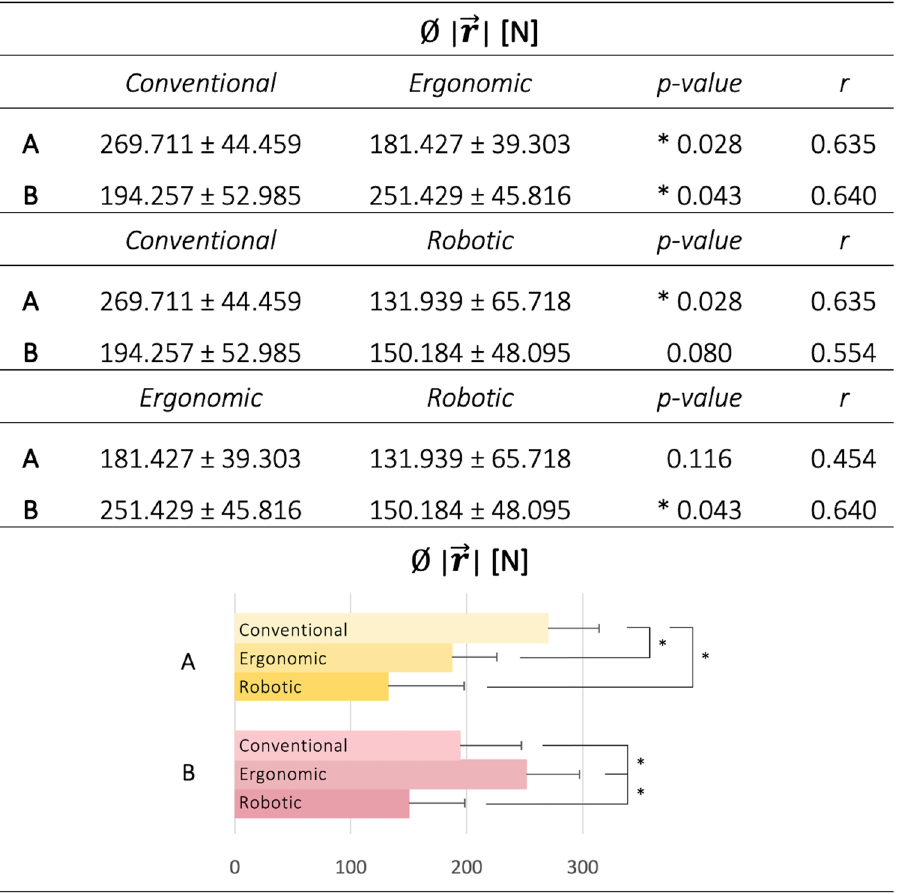
−→ r | for all three manual patient handling tasks. The